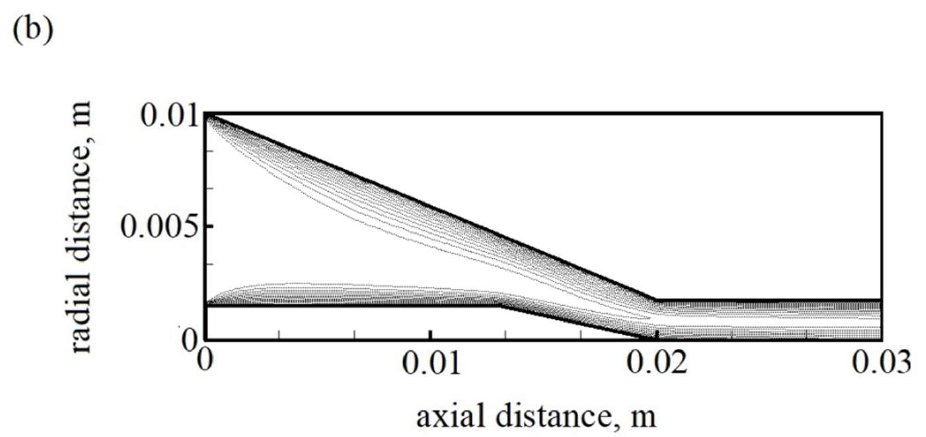
Figure 5. Particle concentration distribution inside the hollow tapered cylinder ( a ) without the conical column and ( b ) with the conical column for the particle diameters of 3 nm at the flow rate of 2 L/min.